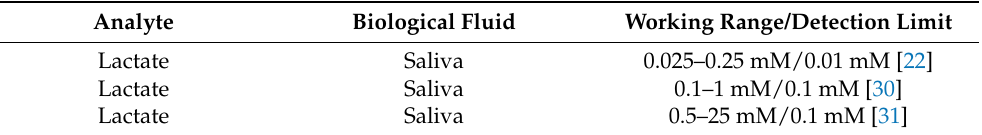
Table 3. Enzyme-based-lactate biosensors developed for salivary lactate